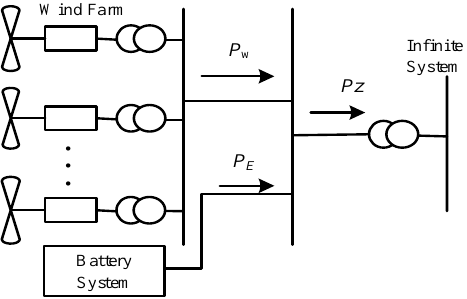
Figure 1. Schematic configuration of wind-battery energy storage, where P W is the output power of the wind farm; P E is the charge/discharge power of the battery storage system; P Z is the output power of the whole system.